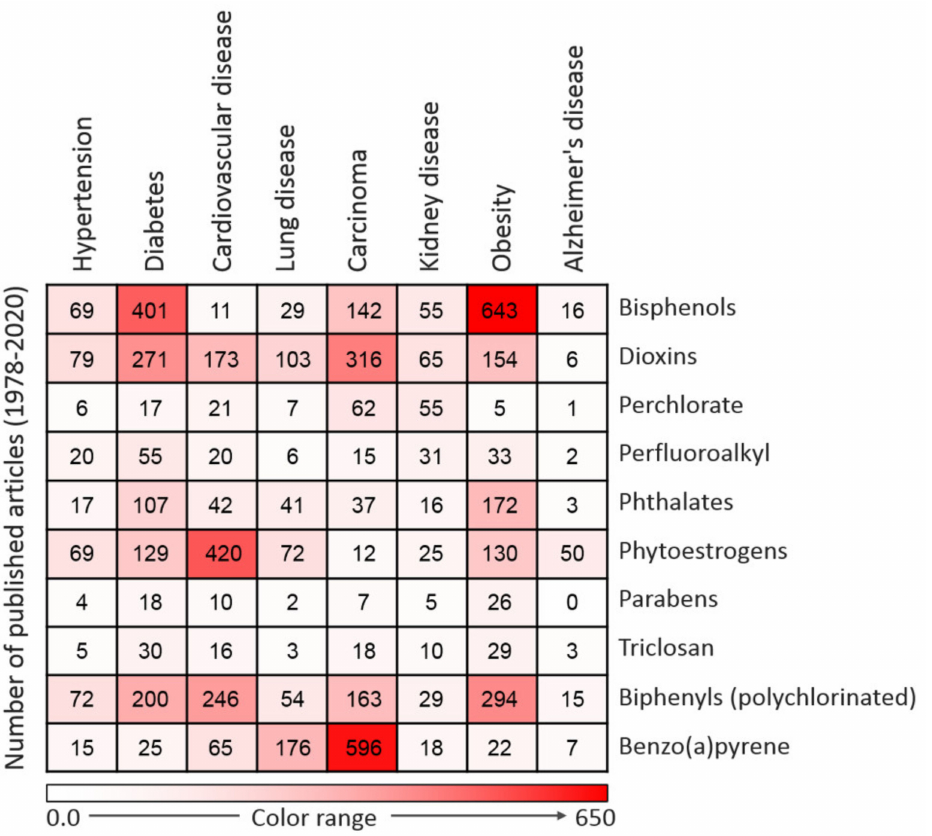
Figure 2. Heatmap representing the number of articles published on the 10 commonly used endocrine- disrupting chemicals (EDCs) in association with particular diseases. Data were collected by a thorough search of the Web of Science database. Only peer-reviewed papers published in English from 1978 to 2020 on specific EDCs and diseases were